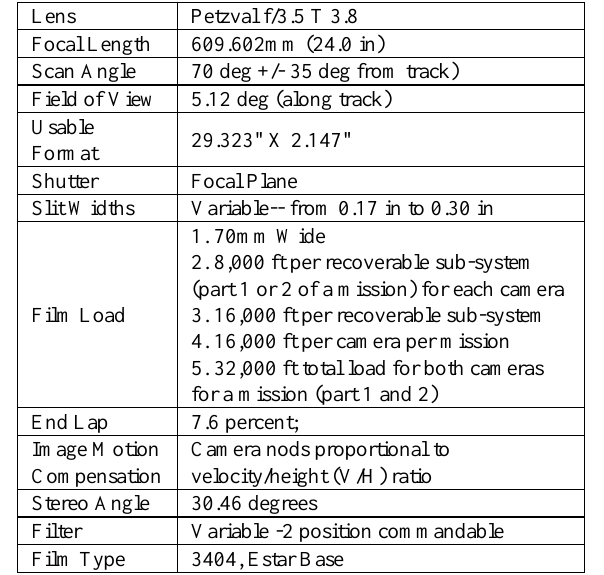
Table 4. Corona panoramic camera specifications [2]